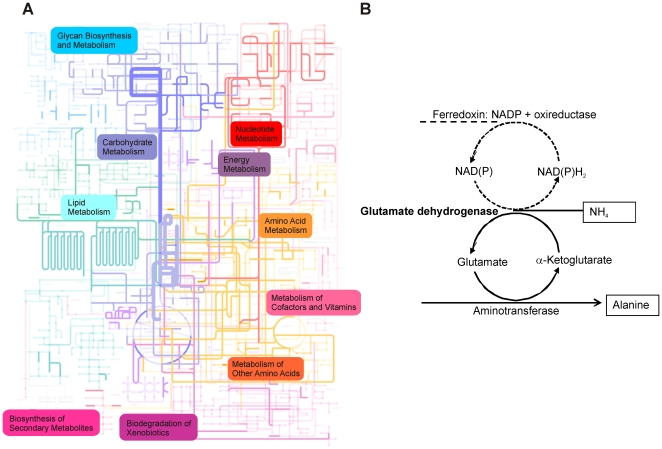
Represented metabolic pathways in the human intestinal metaproteome.A Visualization of all identified metabolic pathways. The pathways “Glycolysis and Gluconeogenesis” (blue) and “Pyruvate Metabolism” (purple) for which most enzymes were identified are highlighted. B Glutamate dehydrogenase reaction. According to Kengen et al. glutamate dehydrogenases may couple amino acid transfer to electron transfer [22]. Glutamate is transformed to alpha-ketogluratae by the consumption of NAD(P) and the assistance of aminotransferases. Ferredoxin-oxidoreductase reduces NAD(P)H2 to NAD(P).